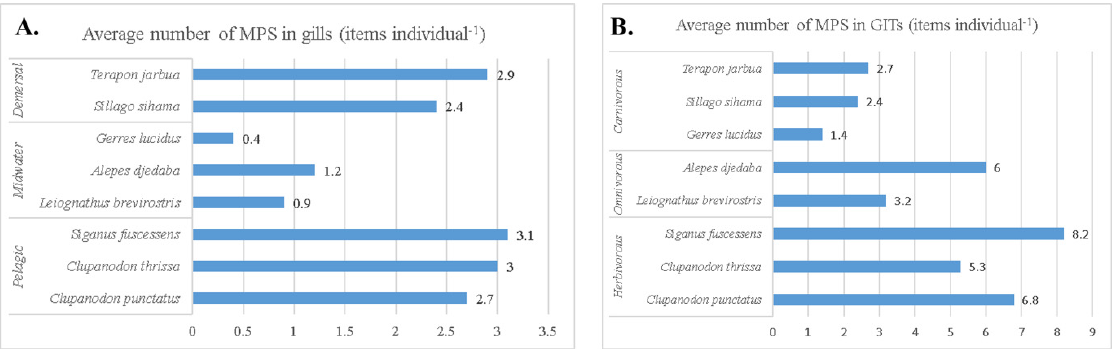
Figure 5. Abundance of microplastic in habitats ( A ) and feeding habits ( B ) in fish samples from the coastal areas of central and western Guangdong province.